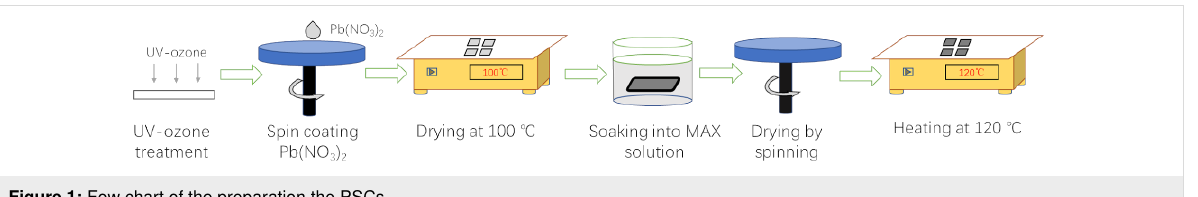
Figure 2: (a–e) SEM images of perovskite films prepared with differ- ent amounts of PVP additives: (a) PVP-0 mg/mL, (b) PVP-0.5 mg/mL, (c) PVP-1 mg/mL, (d) PVP-2 mg/mL, (e) PVP-3